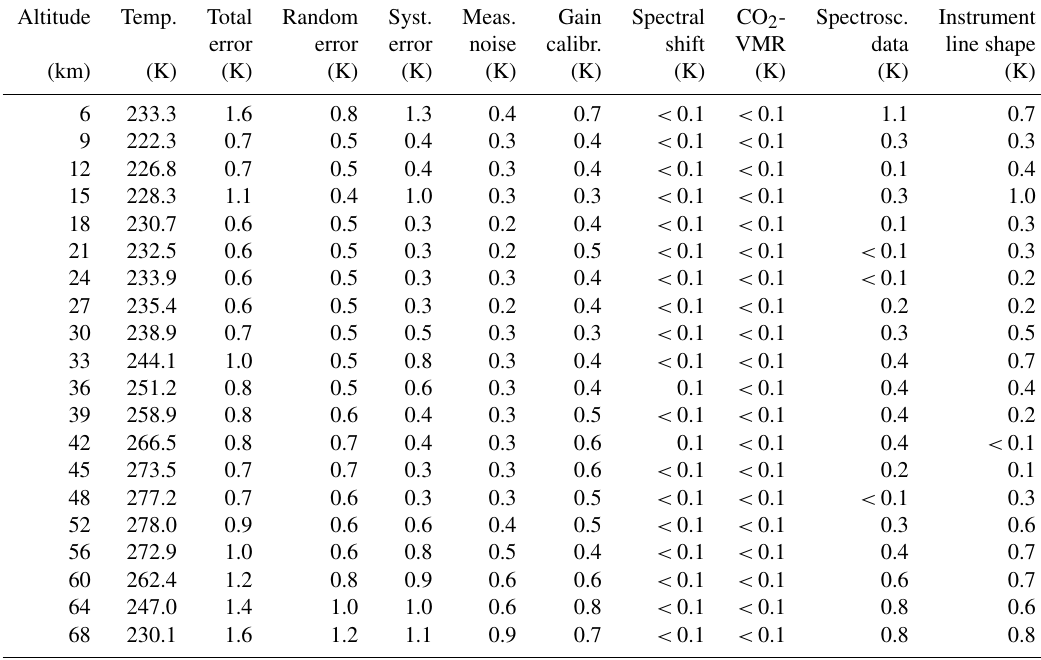
Table A3. RR data temperature error budget for southern polar summer day. All uncertainties are 1 σ . Altitude Temp.